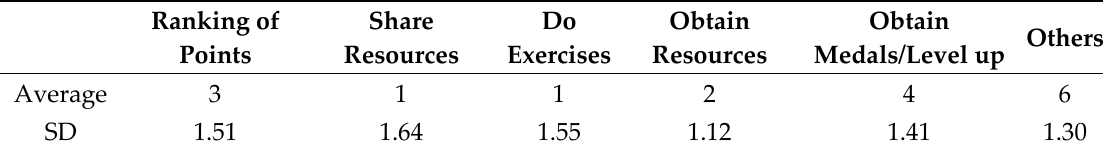
Table 2. Results for the first question for the gamification questionnaire.